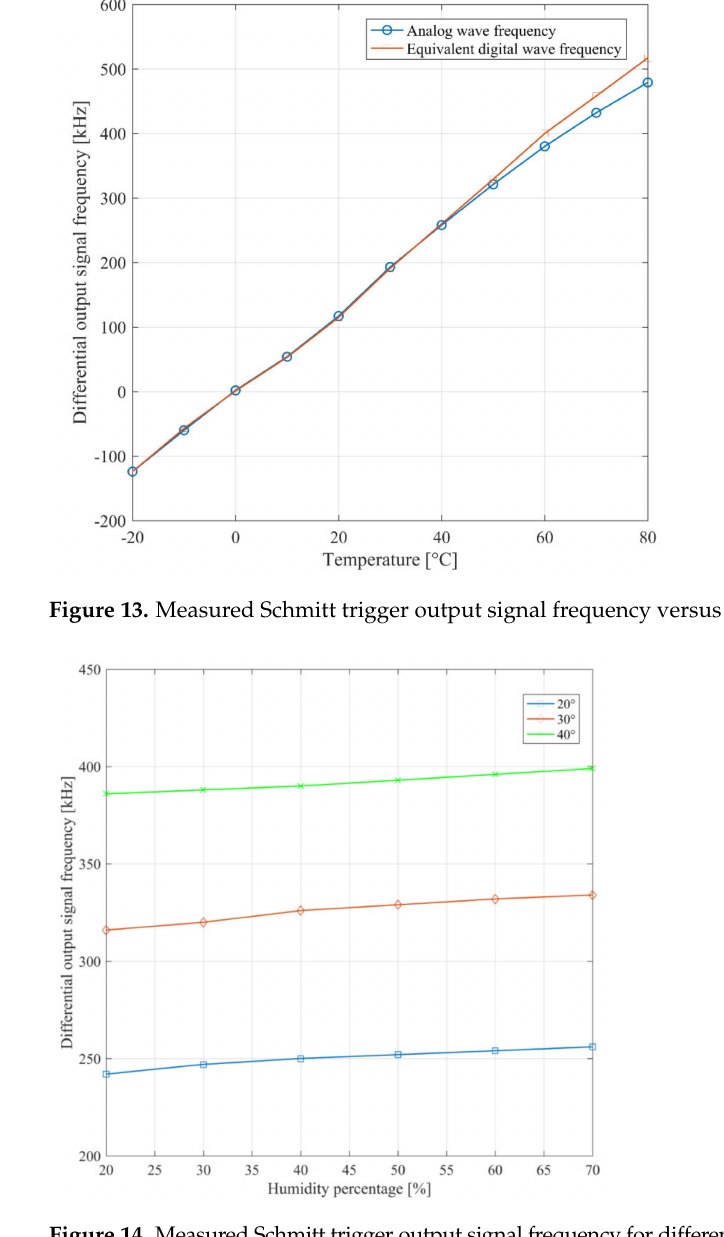
Figure 14. Measured Schmitt trigger output signal frequency for different humidity and temperature val-